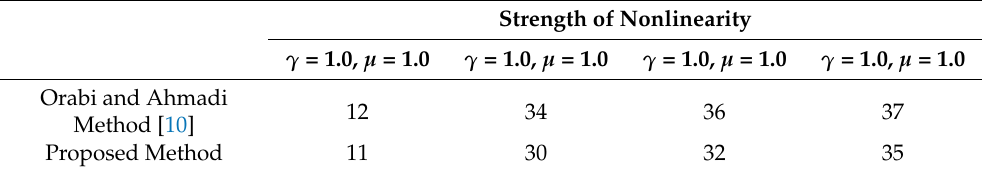
Table 1. Comparison of the number of